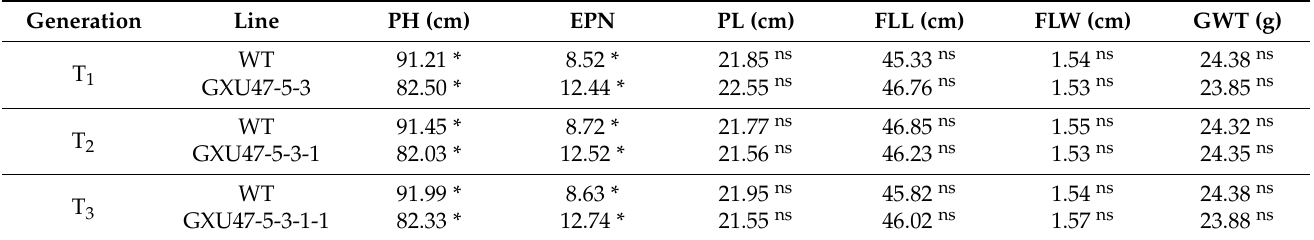
Table 1. Main agronomic traits of wild-type and homozygous mutant lines in the T 1 , T 2 , and T 3